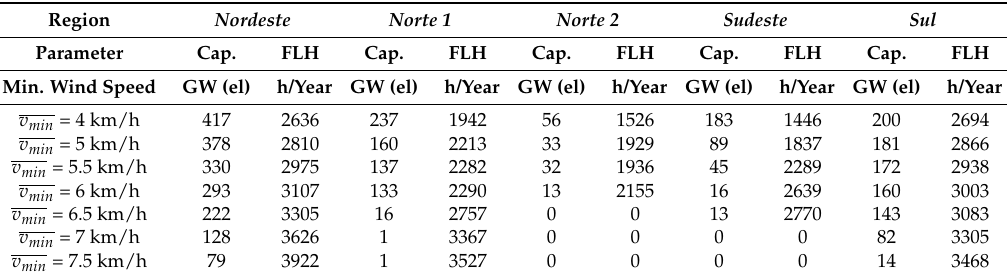
Table A8. Available offshore wind potentials at different average annual wind speeds, evaluated using REMix-EnDAT. Note that installable capacities are displayed in GW and annual full load hours in